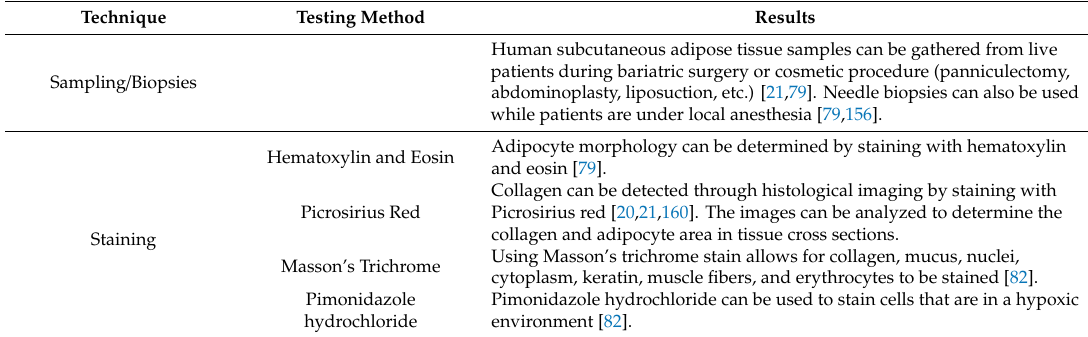
Table 3. Techniques used by researchers to evaluate the presence and degree of adipose tissue fibrosis.